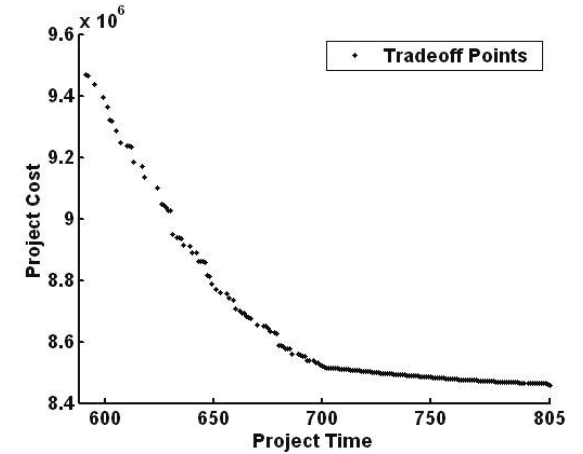
Fig. 14. Tradeoff Points of the final generation population : Third case study